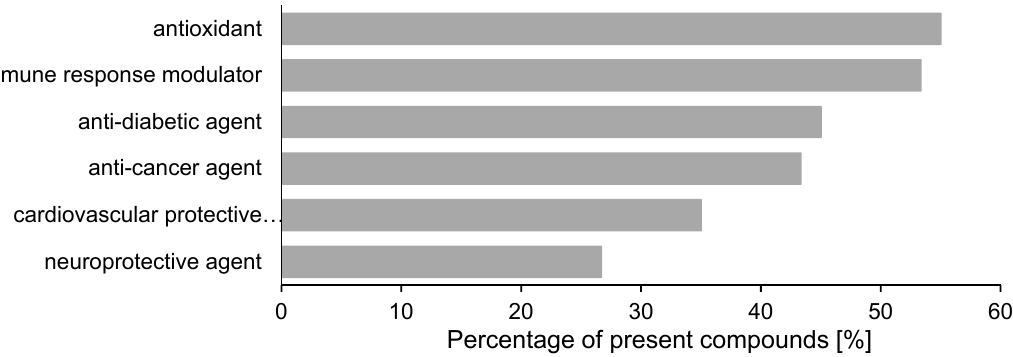
Figure 6. Health benefits of the compounds identified in the three extract formulations, aqueous, methanolic, and hydro-methanolic. Only health promoting effects shown by more than 20% of the phytochemicals are presented. This figure is based on the summarized information in Table S6 [45–261].